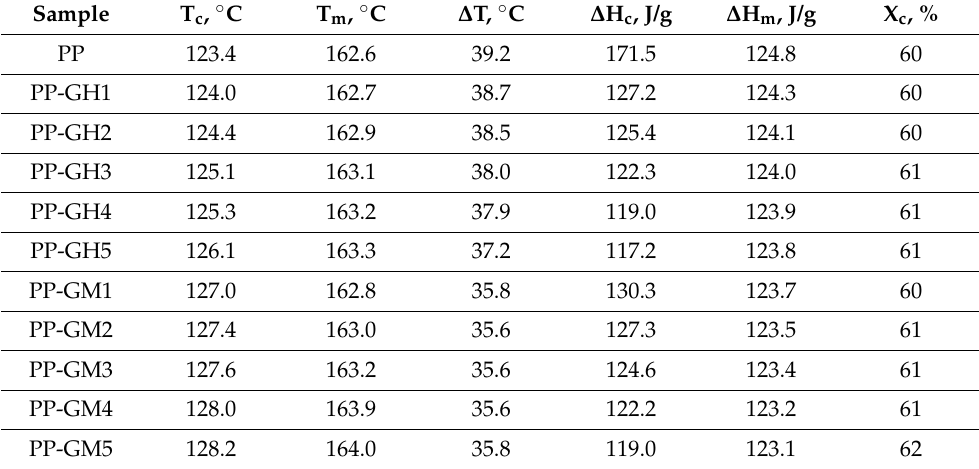
Table 5. Effect of GNP loading on the crystallization behavior of all the samples.